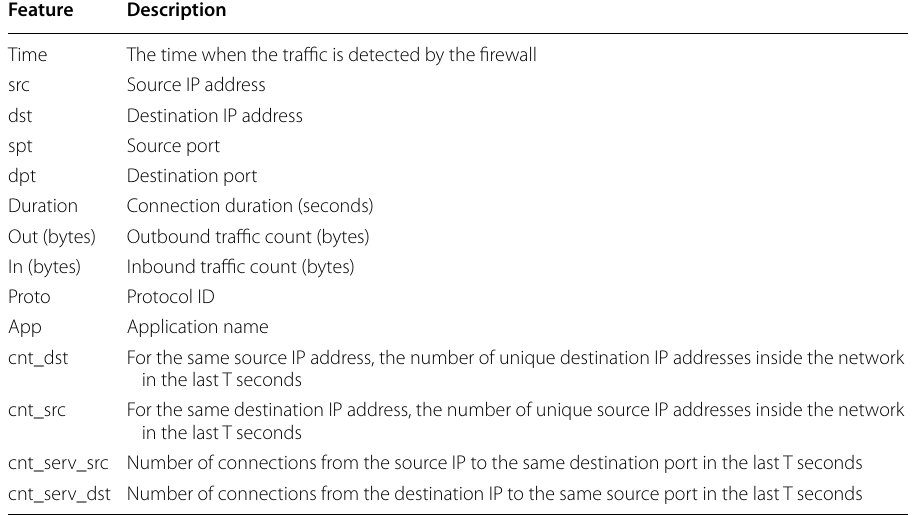
Table 2 The features and descriptions in ZYELL dataset [13]